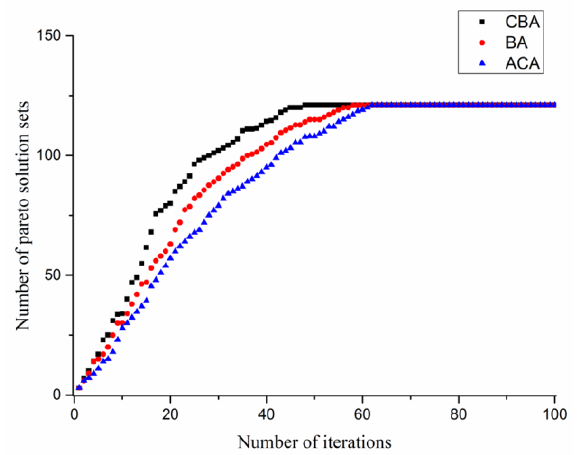
Figure 6. Iterative convergence process.